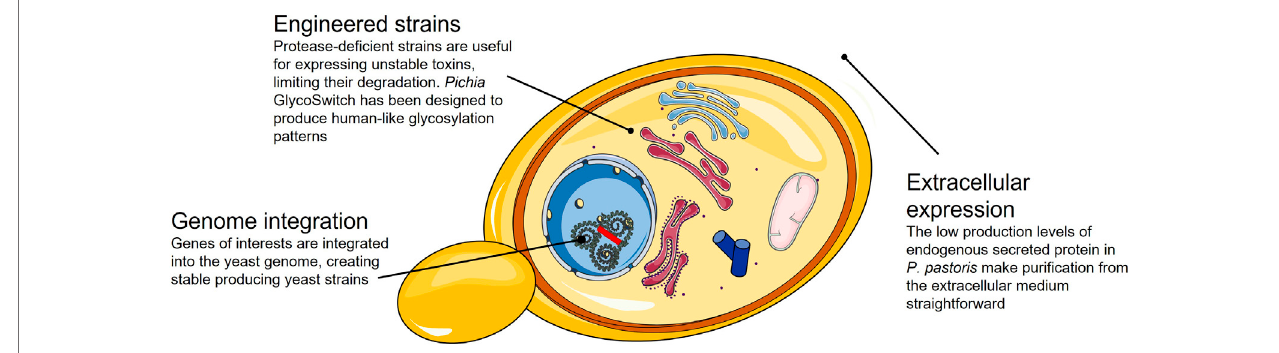
FIGURE 4 | Summary of the strategies available and their advantages for the expression of correctly folded toxins in a P. pastoris expression system.